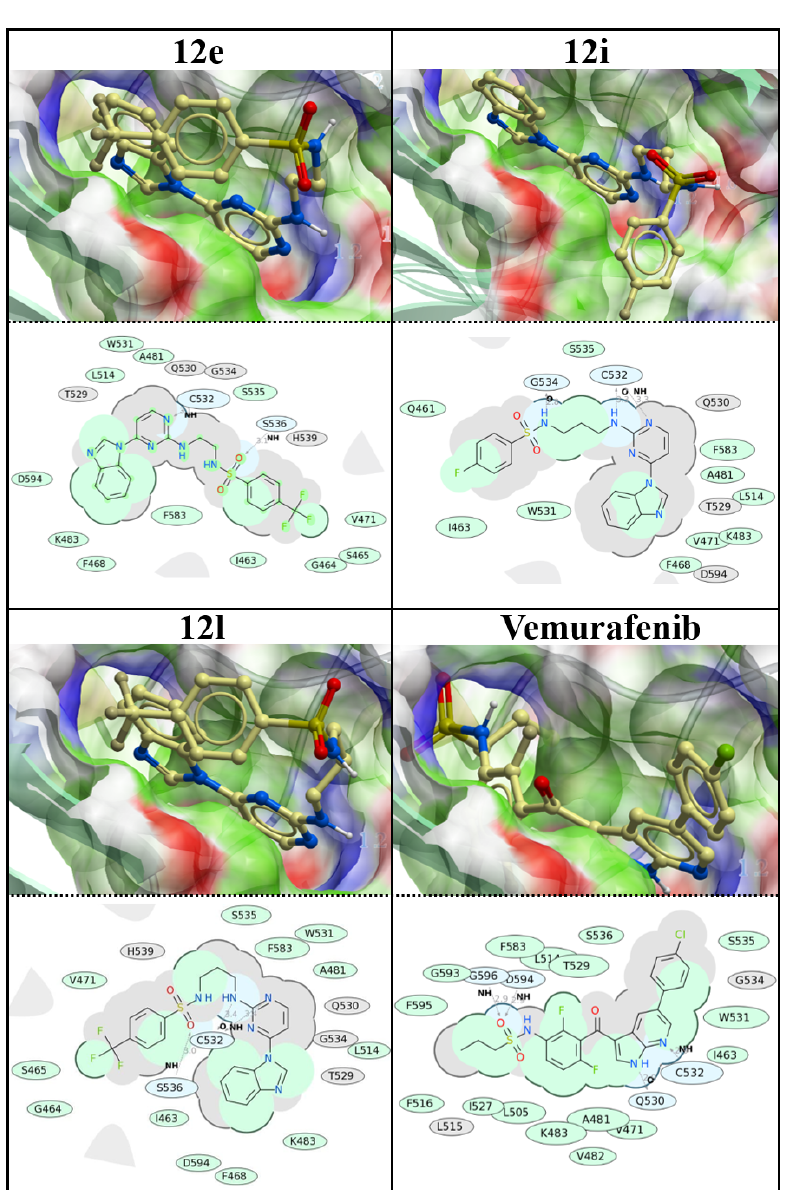
Figure 4. Binding poses of 12e , 12i , 12l and vemurafenib (reference ligand), and 2D diagrams of their interactions with the amino acid residues of V600EBRAF protein.